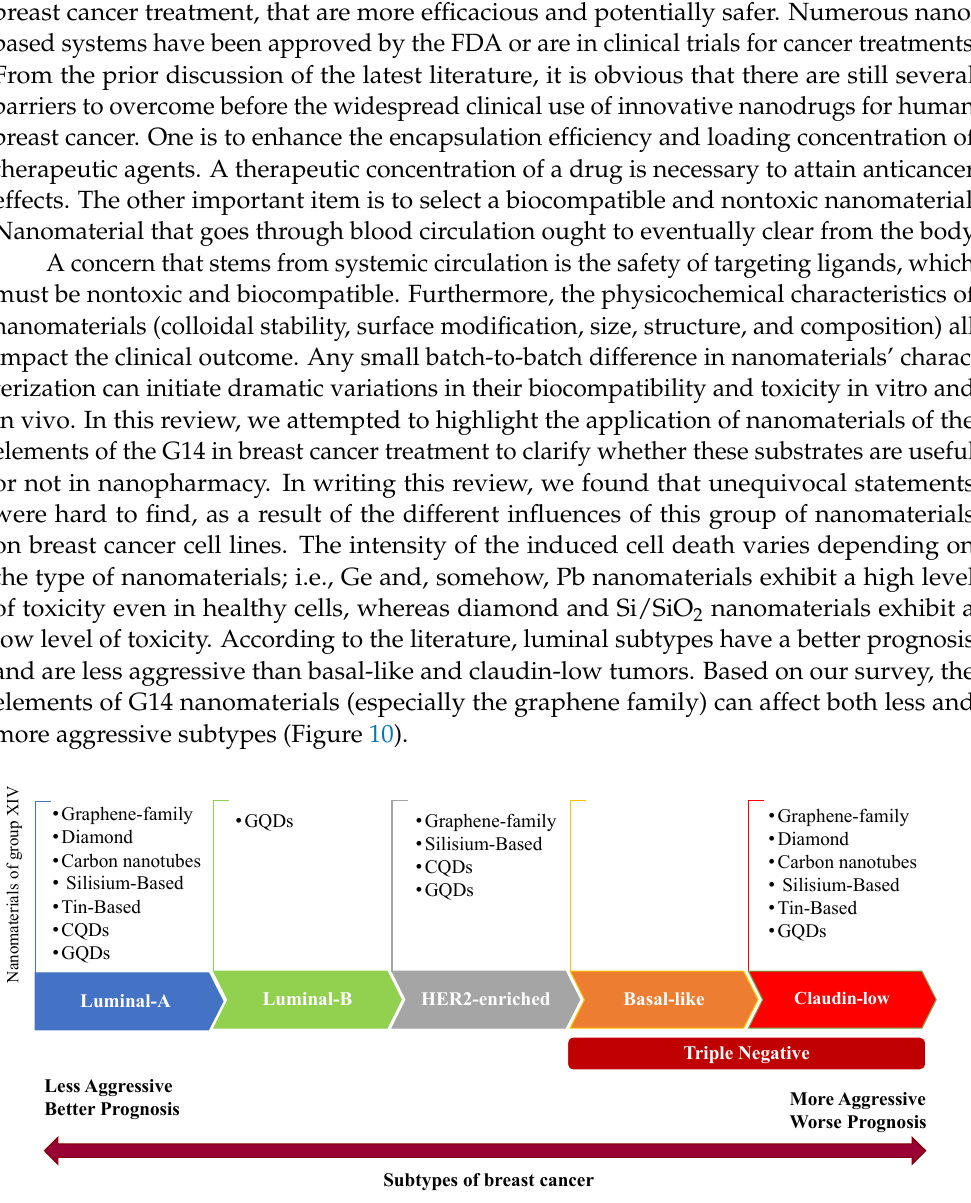
Figure 10. A brief classification of the elements of the G14 nanomaterials applied in different subtypes of breast cancer, based on recent studies. Based on the literature, the elements of G14 nanomaterials can affect both less and more aggressive subtypes.